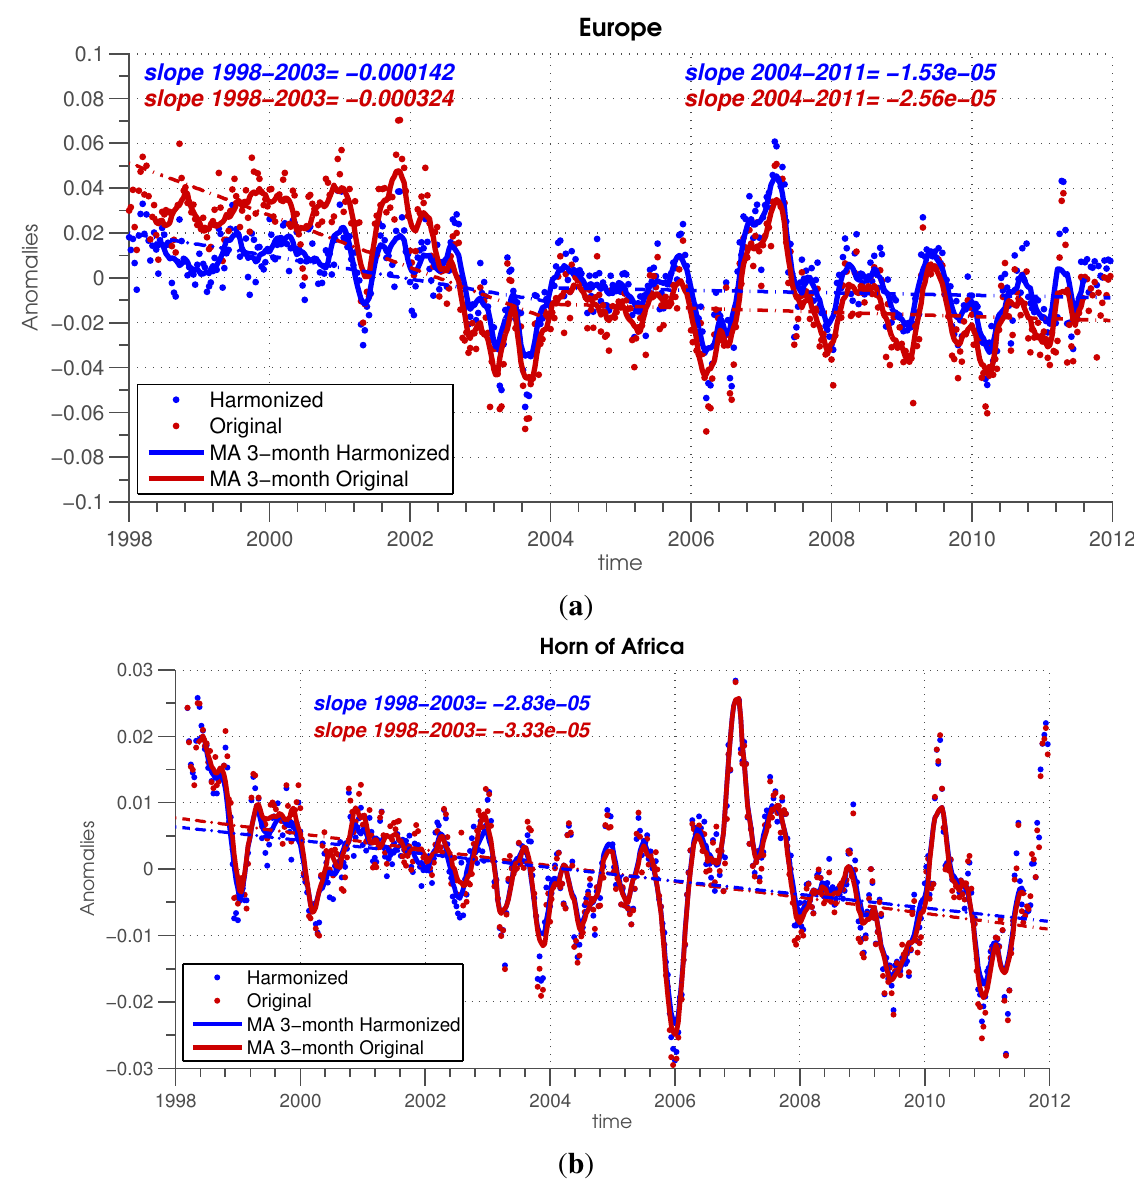
Figure 12. Differences between the anomalies calculated with the original data (red line) and with the harmonized data (blue line) over Western Europe ( a ) and over the Horn of Africa ( b